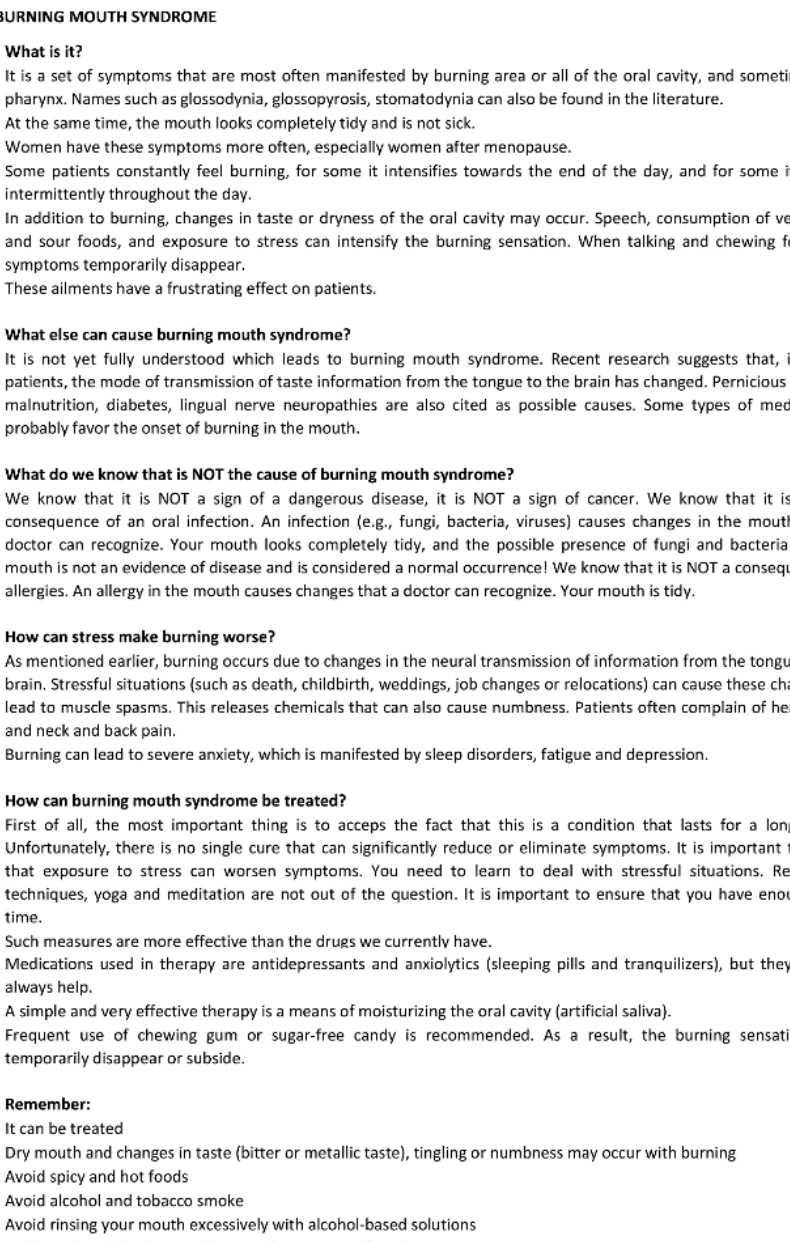
Figure 1. Written information for patients with BMS translated to English.